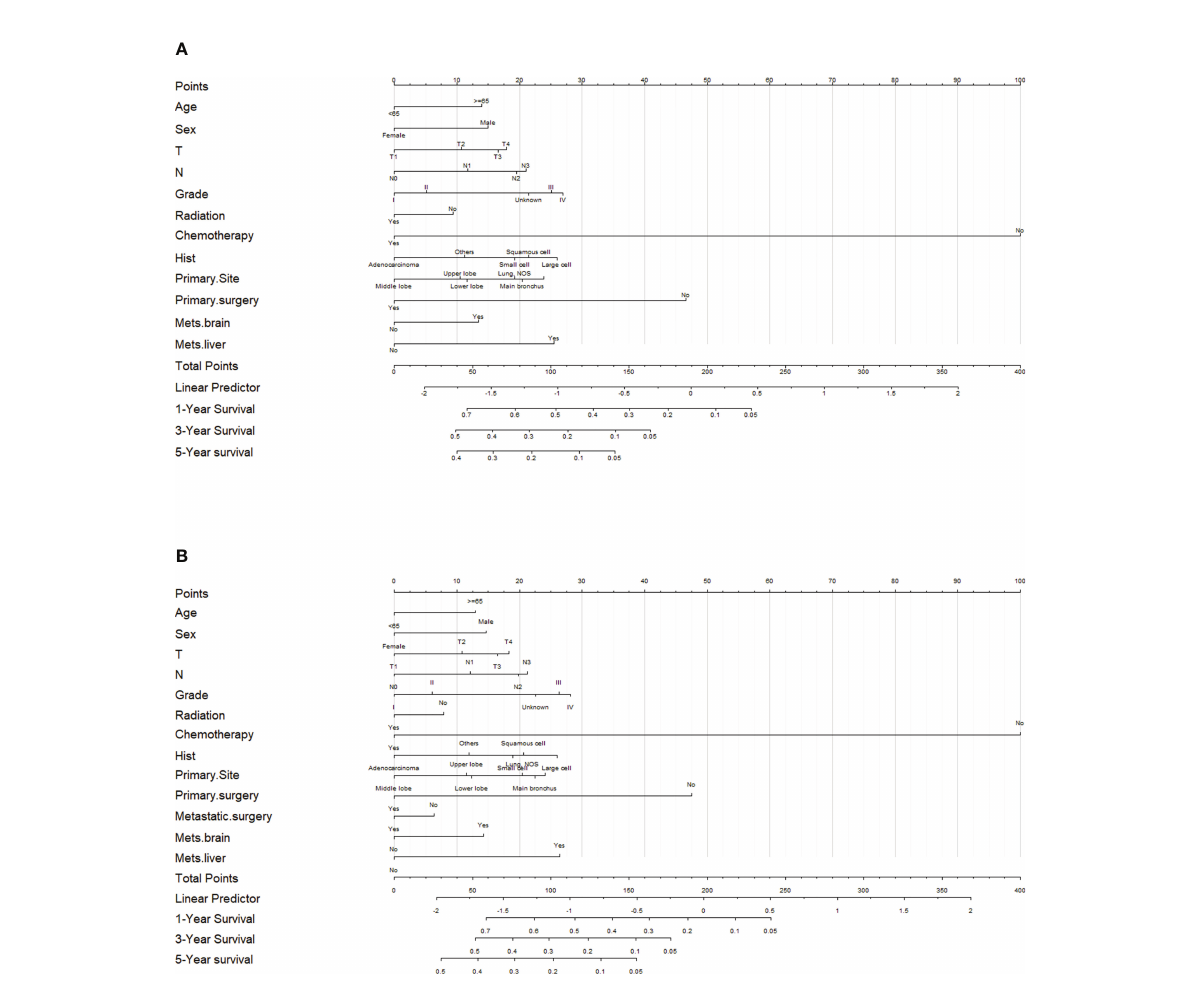
FIGURE 4 Evaluation of the overall survival (OS)- and cancer-speci fi c survival (CSS)-associated nomograms for patients with lung cancer with bone metastasis (LCBM). (A) OS nomogram integrating age, sex, T stage, N stage, grade, radiation, chemotherapy, histology, primary site, primary surgery, mets-brain, and mets-liver for predicting 1-, 3-, and 5-year OS rates. (B) CSS nomogram integrating age, sex, T stage, N stage, grade, radiation, chemotherapy, histology, primary site, primary surgery, metastatic surgery, mets-brain, and mets-liver for predicting 1-, 3-, and 5-year CSS